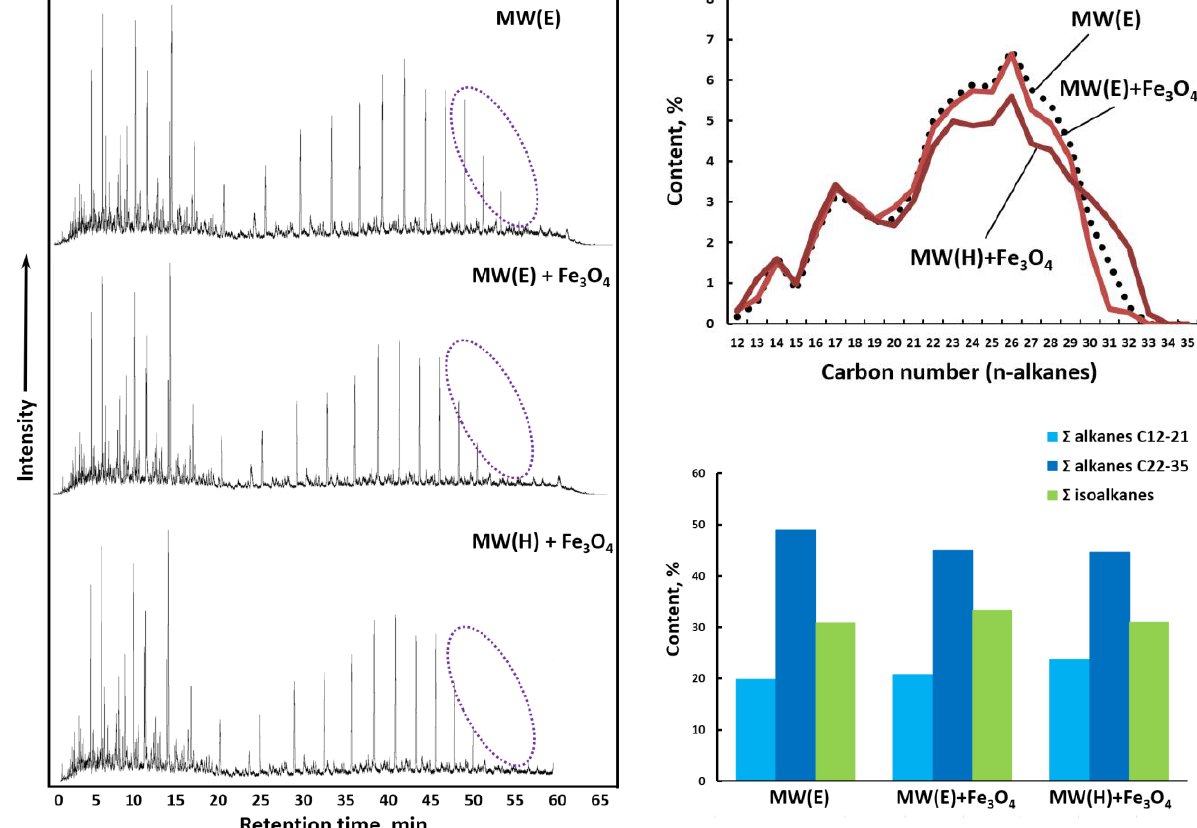
Figure 4. Chromatograms of saturated hydrocarbons C 10 -C 32 —the number of carbon atoms in n-alkanes, iC 13 -iC 18 —i-alkanes. The relative content of normal alkanes in the studied oil samples after exposure to a microwave field. In the lower-right corner—a change in the content of the sum of n-alkanes and isoalkanes.